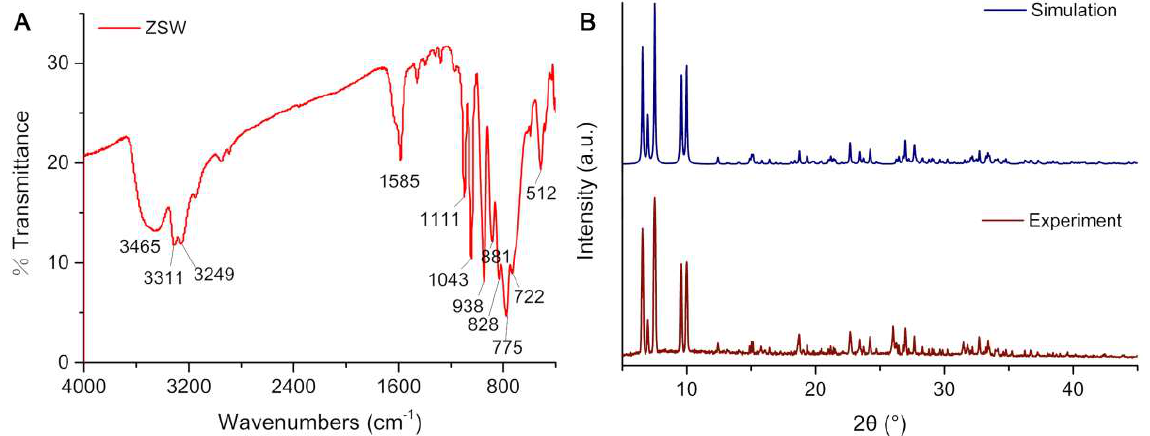
Figure 4. ( A ) IR spectrum for [Zn 2 (4,4′-bpy)(Phen) 2 ][SiW 12 O 40 ] (ZSW), 4,4′-bipyridine (4,4′-bpy), 1,10- phenanthroline (Phen); ( B ) PXRD patterns of ZSW.